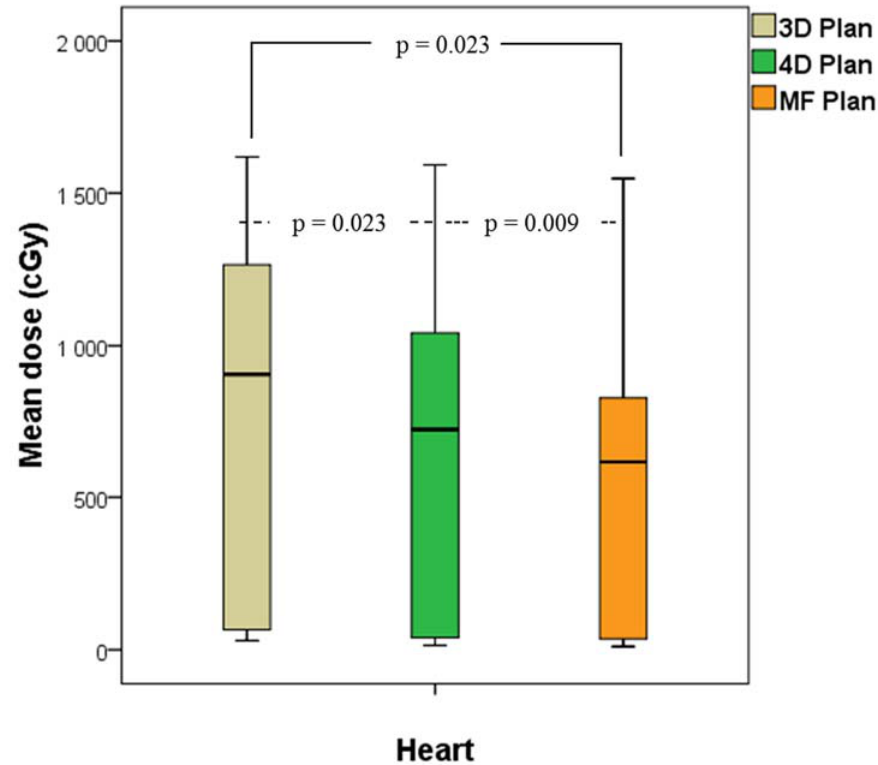
Figure 6. Box plot of the mean radiation dose received by the heart for the three treatment plans. Appl. Sci. 2018 , 8 , x FOR PEER REVIEW